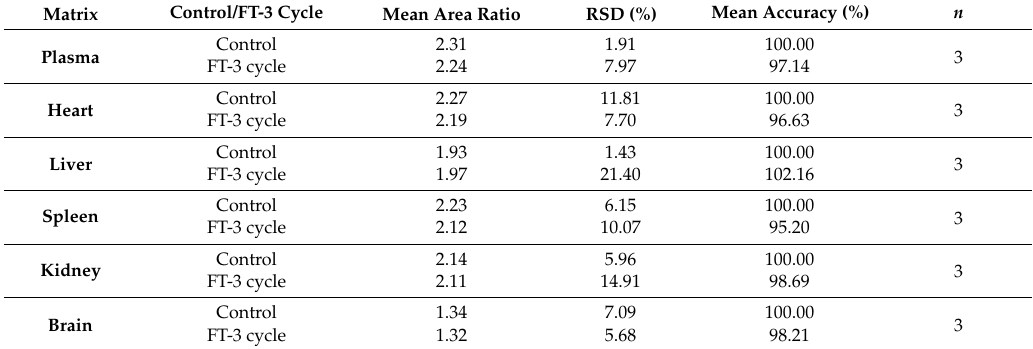
Table 4. Freeze-thaw stability results for GB3.